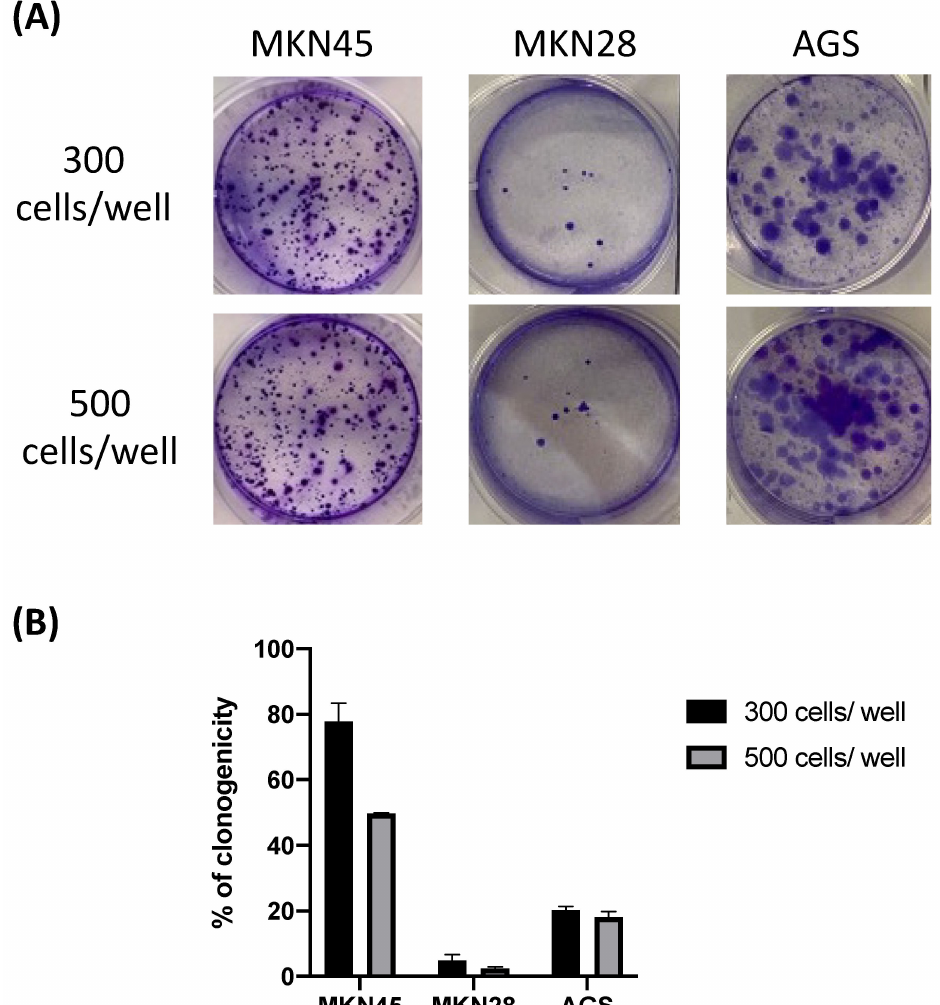
Figure 3. Results of the colony formation assay of MKN45, MKN28, and AGS cell lines performed 14 days after the seeding in cases of MKN28 and AGS and 21 days after seeding in the case of MKN45. Macroscopic visualization of the crystal violet-stained colonies ( A ) and percentage of colonies formed ( B